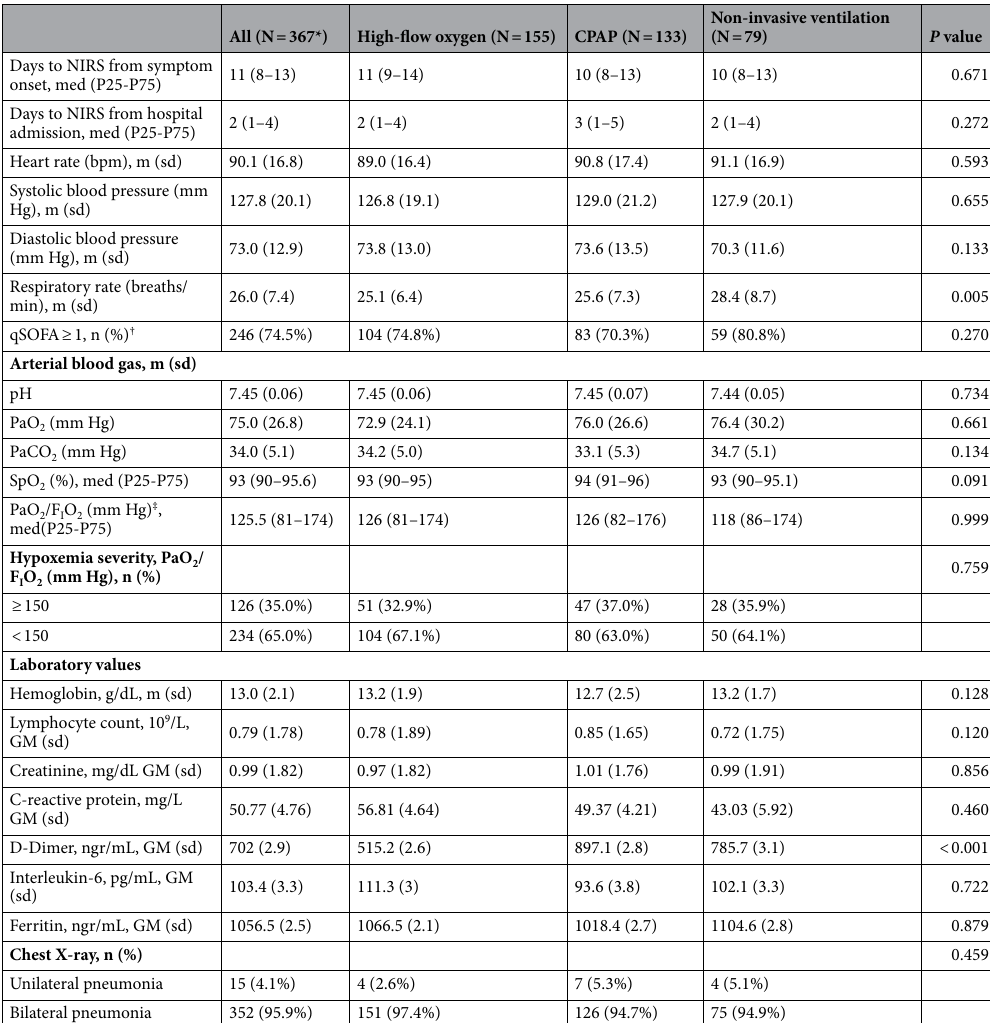
Table 2. Patients’ characteristics at the time of initiating non-invasive respiratory support. P-value from Chi 2 test (categorical), Anova (continuous). FiO 2 fraction of inspired oxygen; GM Geometric Mean, NIRS non- invasive respiratory support,